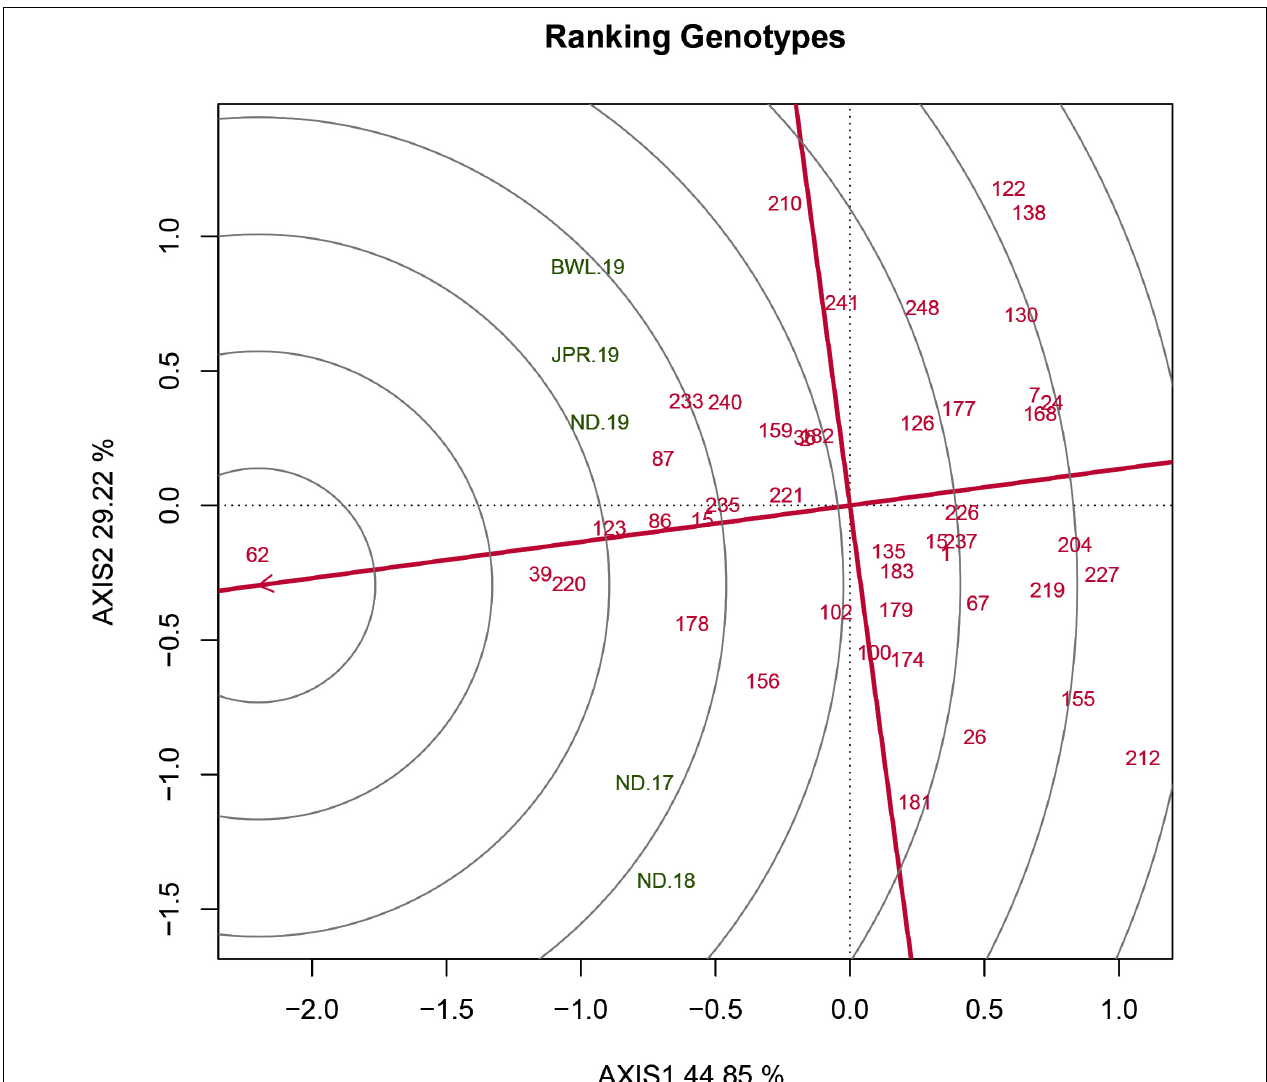
FIGURE 6 | Genotype ranking plot view of the GGE biplot of 43 resistant genotypes across five testing environments. There was heritability-adjusted scaling of data where the environment standardized data were multiplied by the heritability in each environment (transform = HA), and data were centered using the environments (centering = 2). The biplot was based on “row metric preserving” (SVP = 1), which means the singular values were partitioned into the genotype eigenvectors for visualizing the correlation among genotypes. Numbers correspond to genotypes as listed in Supplementary Table 1 . Environment: ND-17, New Delhi-2017; ND-18, New Delhi-2018; ND-19, New Delhi-2019; BWL-19, Bawal-2019; JPR-19,